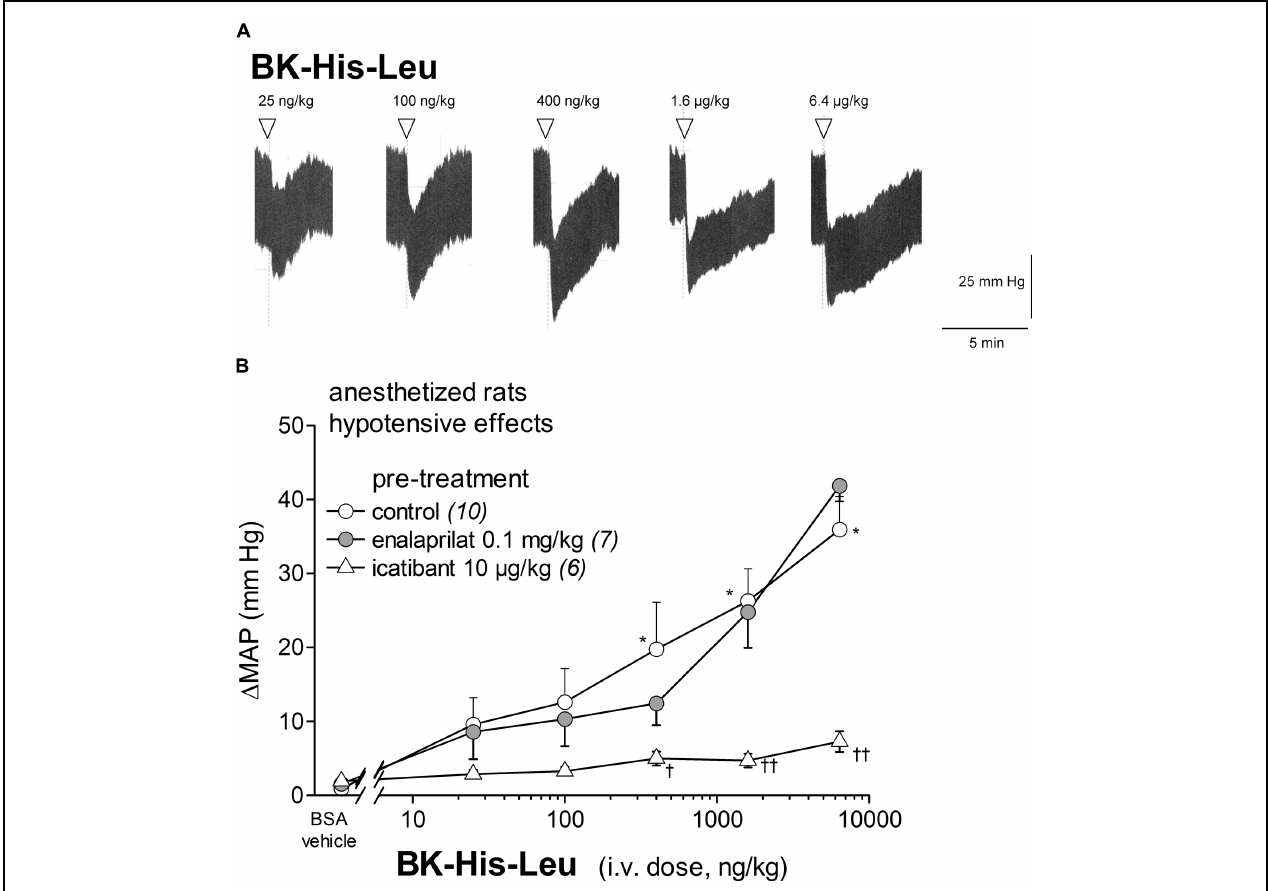
FIGURE 6 | Hypotensive responses to i.v. bolus injections of increasing doses of BK-His-Leu in anesthetized rats. (A) Representative traces showing the dose-response effect of BK-His-Leu on systemic pressure. Doses of BK-His-Leu are in ng/kg. Abscissa: time; ordinate: arterial pressure (mm Hg). (B) Effect of i.v. pretreatment with enalaprilat (0.1 mg/kg) or icatibant (10 µ g/kg) on the maximal hypotensive response to i.v. injections of increasing doses of BK-His-Leu. The pretreatment with the peptidase inhibitors was given as bolus 15 min before starting the injections of BK-His-Leu. The number of determination in different animals is given between parentheses for control and each inhibitor. Abscissa: dose (ng/kg); ordinate: fall of (MAP; mm Hg). Values are means ± SEM. ∗ P < 0.01 control group values compared with vehicle value; † P < 0.05; †† P < 0.01 pretreated group values compared with the control group values (Dunnett’s